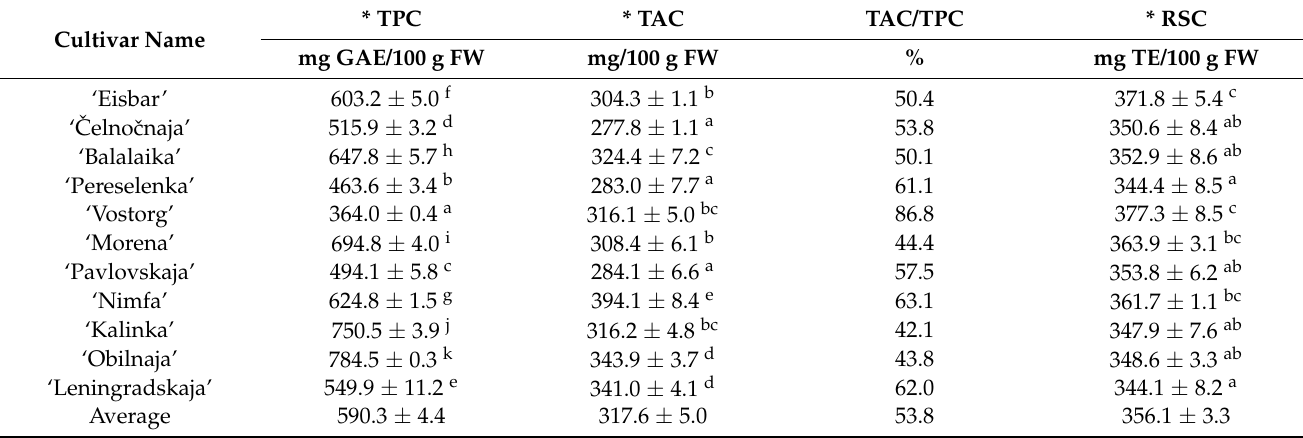
Table 3. Total phenolic content (TPC), total anthocyanin content (TAC), their ratio (TAC/TPC), and DPPH • radical scavenging capacity (RSC) (means ± SD) in berries of Lonicera caerulea